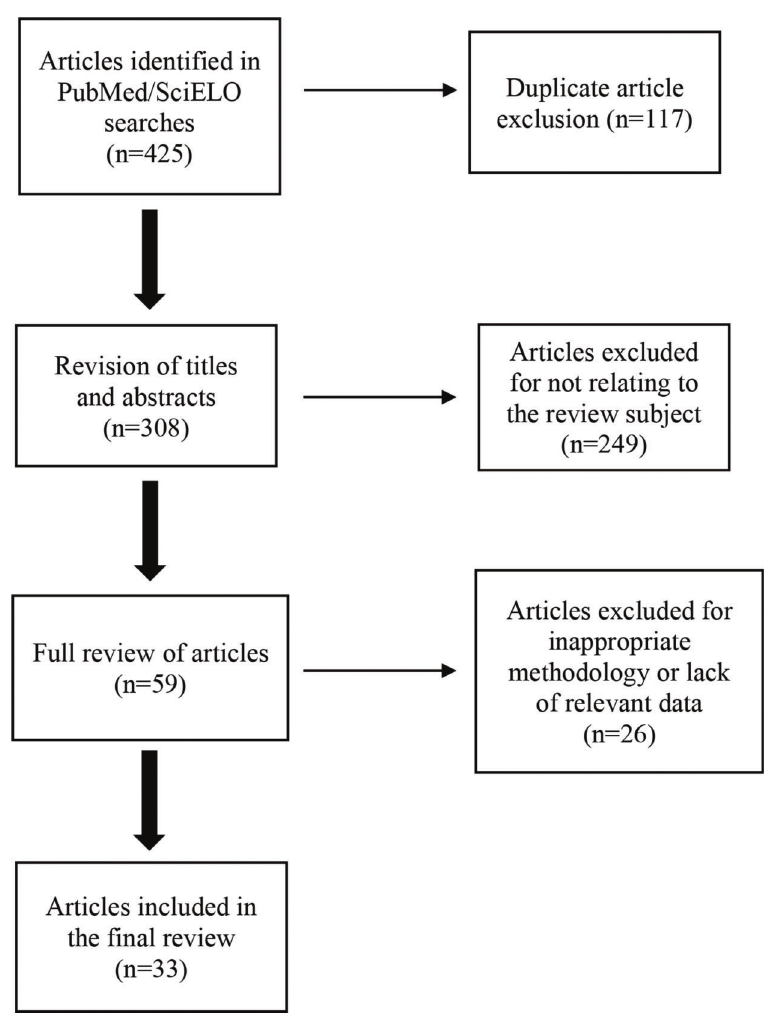
Figure 1 - Flowchart of the selection of articles included in the literature